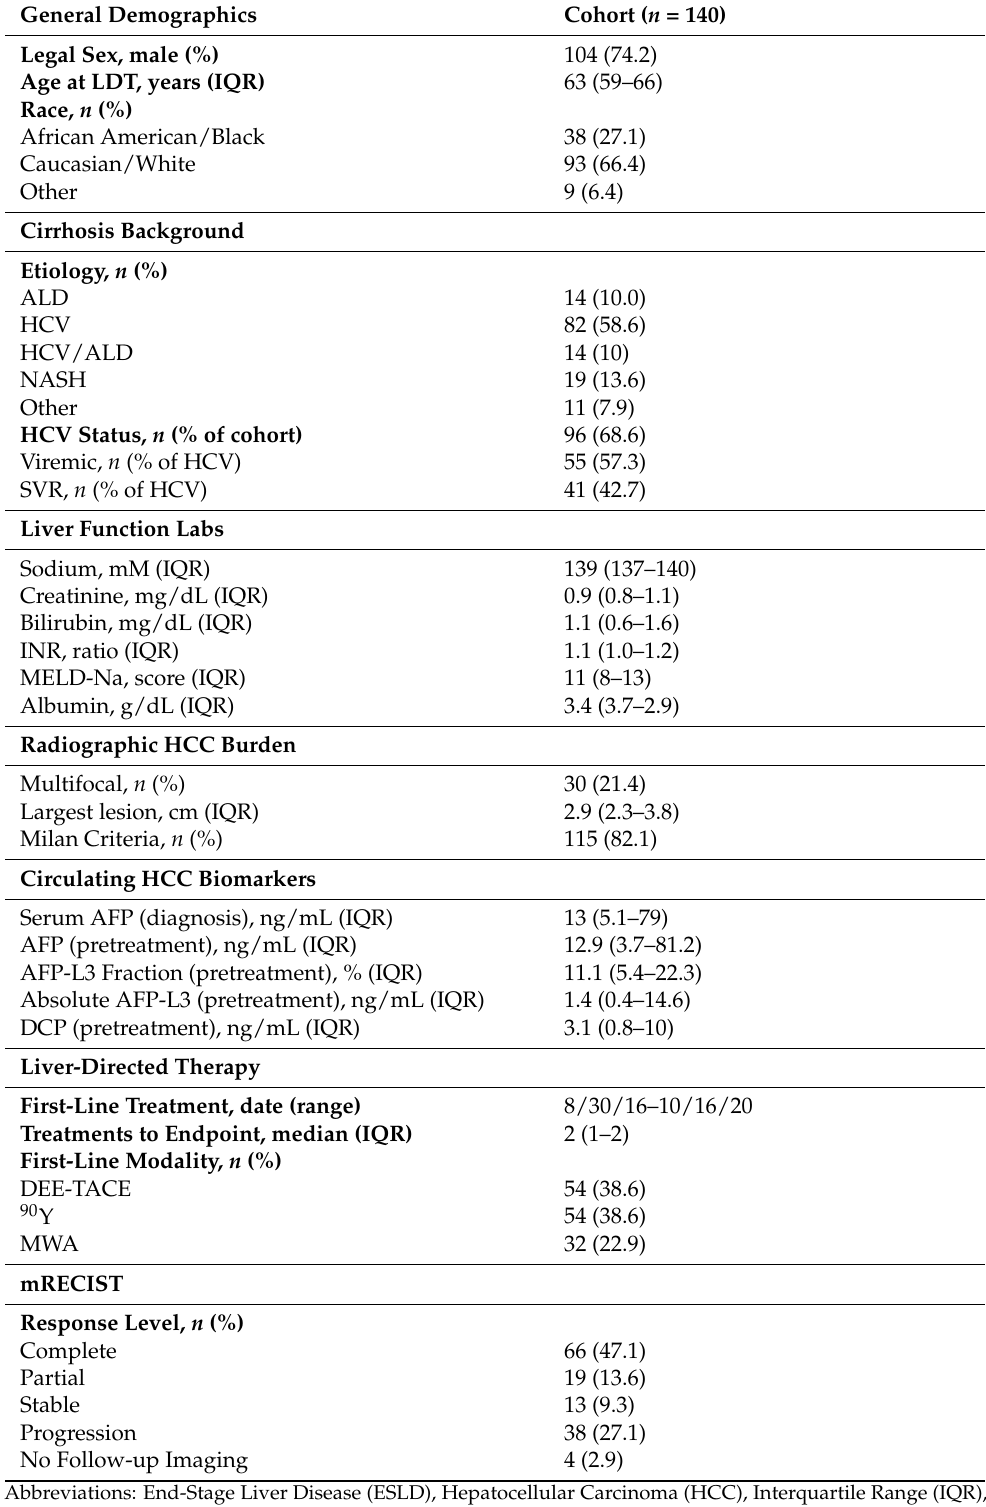
Table 1. Bridge to Transplant Cohort Demographics, Baseline End-Stage Liver Disease Factors, and Tumor